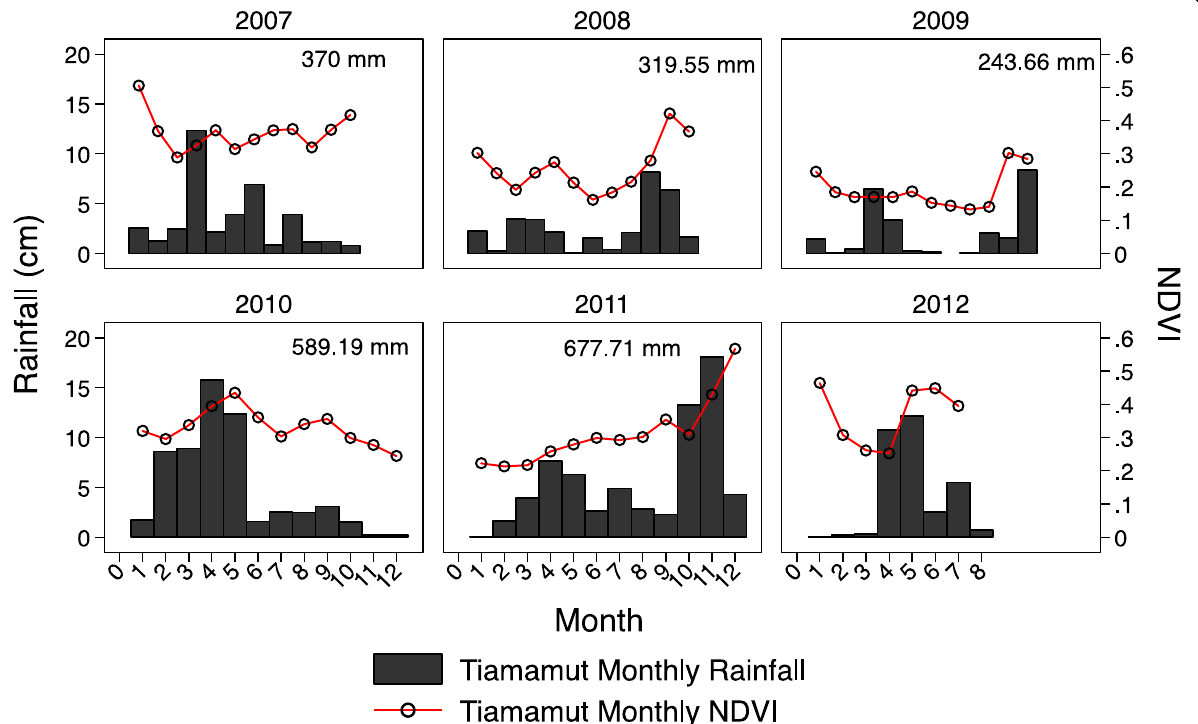
Figure 4 Monthly rainfall and NDVI values for the Tiamamut group ranch over a five-year period (2007 to 2012). Yearly rainfall values for each year are superimposed on the graph in the upper right-hand corner of each quadrant of the graph. The red connected line indicates NDVI whereas the black bars indicate average rainfall (cm)